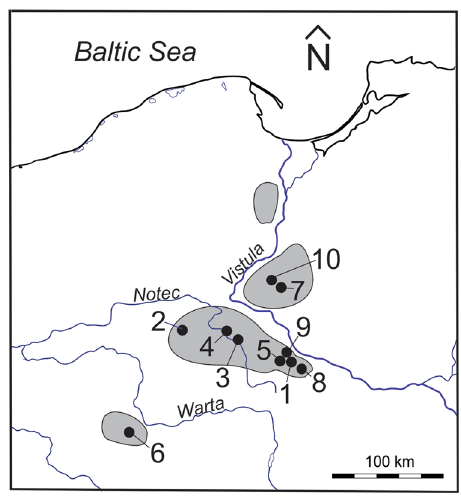
Figure 1: Map of lower Vistula valley and adjacent parts of the Warta - Notec drainage showing areas of settlement of the Brze ść Kujawski Group ( shaded ) and sites mentioned in text, in order of appearance. Key: ( 1 ) Brze ść Kujawski 3, 4; ( 2 ) Biskupin 15a; ( 3 ) Krusza Zamkowa 3; ( 4 ) Ko ś cielec Kujawski 16; ( 5 ) Os ł onki 1, 1a/Konary 1, 1a/Miechowice 4, 4a; ( 6 ) Racot 18; ( 7 ) Zelgno 12; ( 8 ) Kruszynek 6/Ludwinowo 2, 3; ( 9 ) Bodzia 1/Dubielewo 8; ( 10 ) Ż ygl ą d